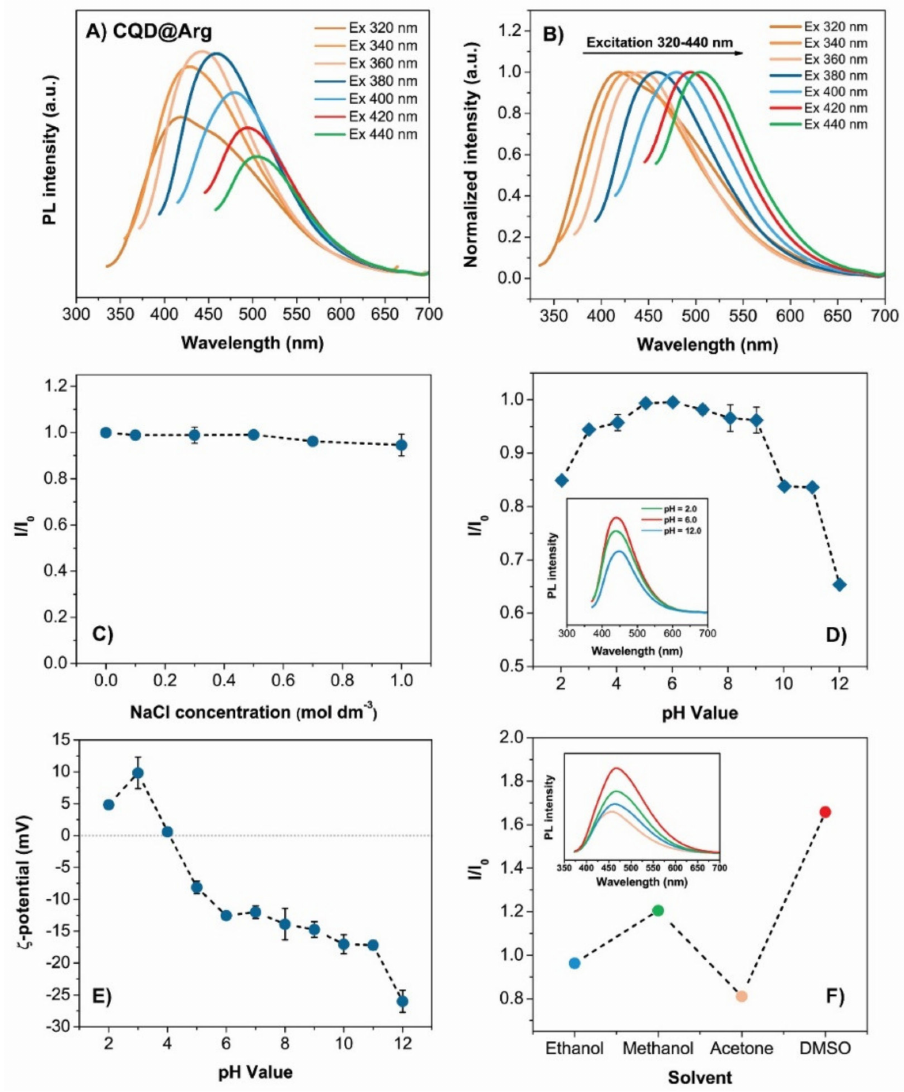
Figure 4. Optical characterization of CQD@Arg: ( A ) Fluorescence emission spectra of CQD@Arg at different excitation wavelengths ranging from 320 nm to 440 nm (increments of 20 nm); ( B ) nor- malized fluorescence emission intensity, ( C ) stability of CQD@Arg in the high ionic medium of NaCl (0–1.0 mol dm − 3 ; λ Ex = 360 nm); ( D ) fluorescence intensity vs. pH variation ( λ Ex = 360